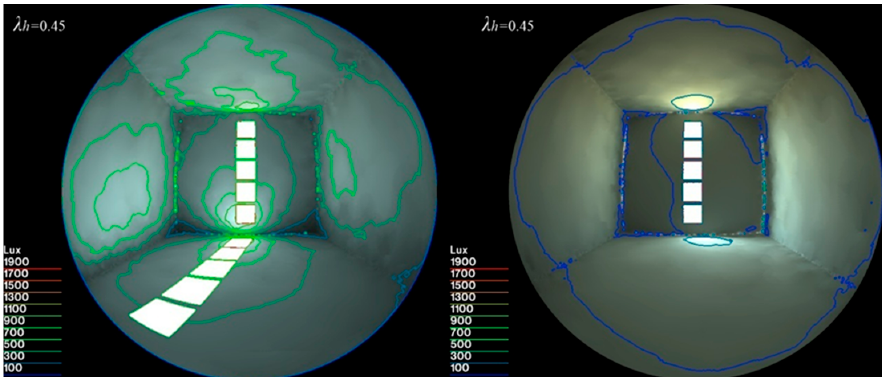
Figure 19. Radiance rendered views for λ h = 0.45 in the south- and west-facing orientations at 12:00 p.m. 21 December (standard meteorological year).